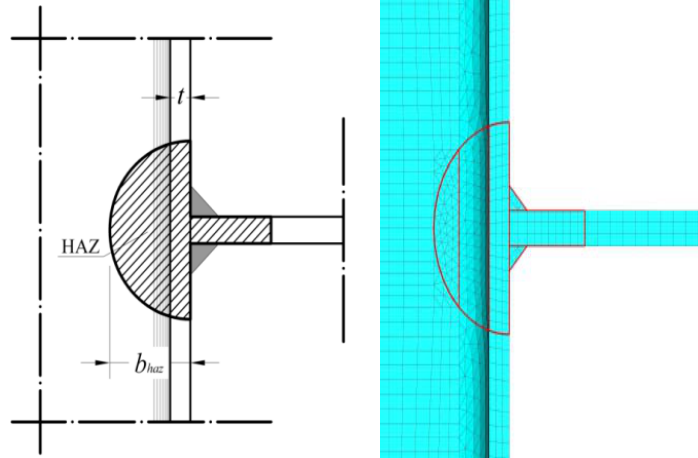
Figure 7. Heat affected zone extent according to Eurocode 9.